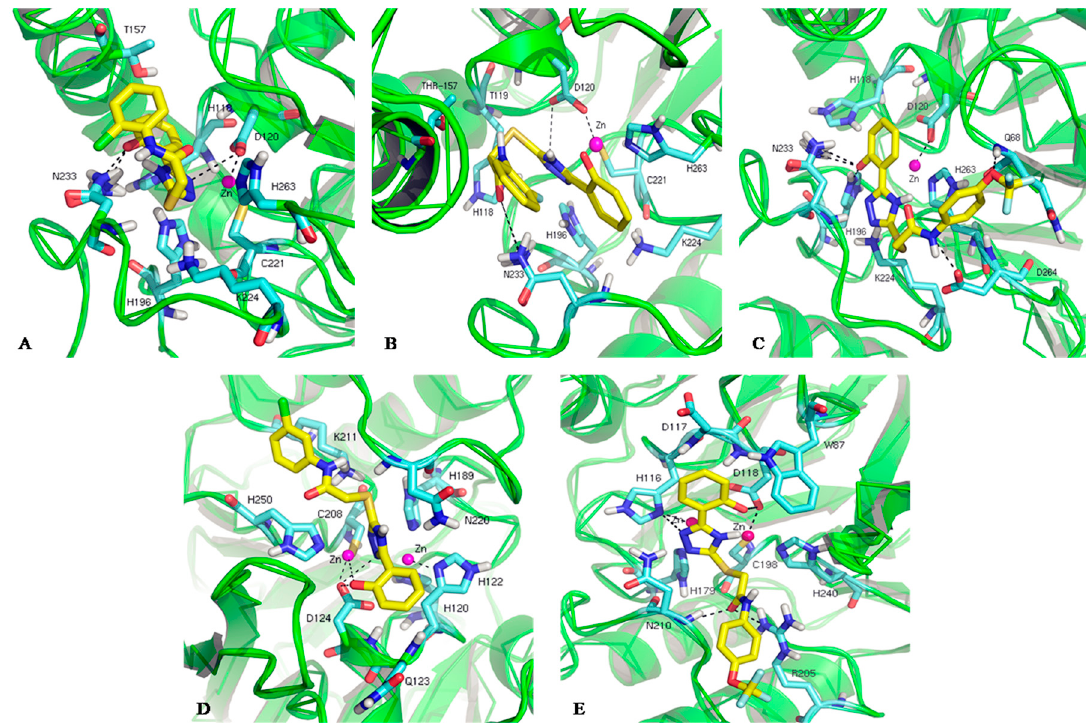
Figure 3. Low energy conformations of 1, 9 and 13 docked into the active site of CphA (PDB code 2QDS) ( A – C ), 2 docked into NDM-1 (PDB code 4EYL) ( D ) and 13 docked into VIM-2 (PDB code 4NQ2) ( E ). The enzyme backbone is shown as cartoon in green, and the Zn(II) ions are shown as magenta spheres. Colored sticks by element were used to show ligand (C, yellow; N, blue; O, red; S, sand; Cl, viridis; F:cyan; H, grey) and the residue side chains (C, cyan; N, blue; O, red; S, yellow; H, grey). The interactions between the inhibitors and enzyme residues were displayed by dashed lines.